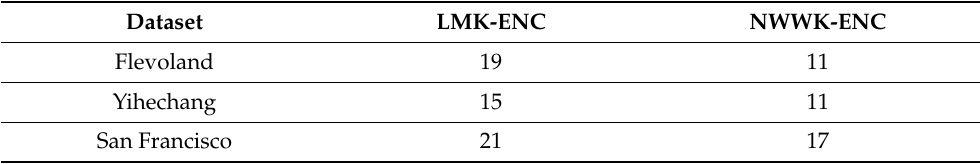
Table 1. Detailed R settings for different